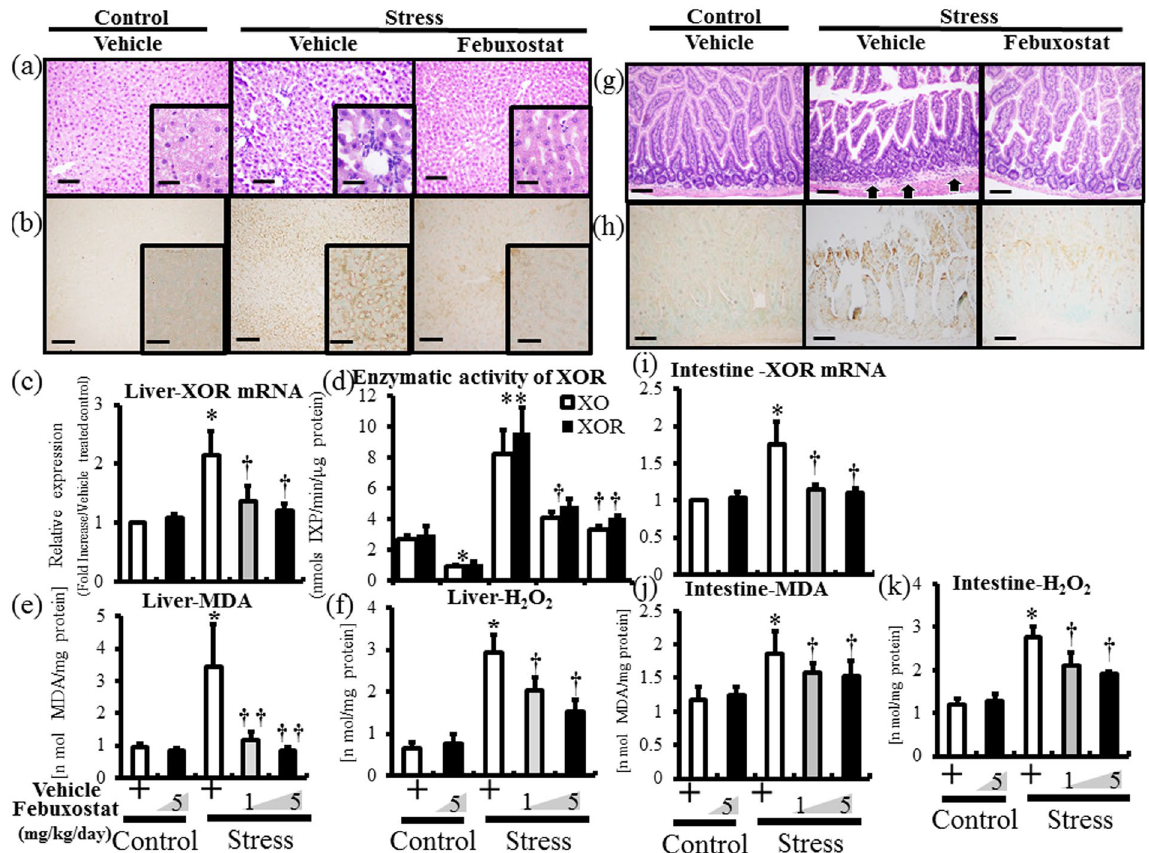
Figure 5. Febuxostat reduces stress-induced xanthine oxidoreductase activation and free radical production in liver and intestine. Expression levels of XOR in liver and intestine and activities of XOR in liver were analyzed in the control (non-stressed) and stressed mice treated with or without febuxostat (1 or 5 mg/kg/day), by immunohistochemistry, RT-PCR and XOR activity assay, respectively. The expression levels of MDA and H 2 O 2 production were analyzed in homogenized liver and intestine tissues of the control (non-stressed) and stressed mice treated with or without febuxostat (1 or 5 mg/kg/day) by ELISA. Data were analyzed by Student’s t-test and displayed as mean ± SD of 5–6 mice per group. Representative pictures of HE ( a ) and XO ( b ) staining of liver ( × 400 magnification, bar = 25 µ m; Inset, × 1000 magnification, bar = 10 µ m). ( c ) XOR mRNA expression in liver. * P < 0.002, compared with the vehicle-treated control mice, † P < 0.05, compared with the vehicle- treated stressed mice. ( d ) XO and XOR (XO + XDH) enzymatic activity in homogenized liver tissue. * P < 0.05 and ** P < 0.02, compared with the vehicle-treated control mice, † P < 0.03 and †† P < 0.02, compared with the vehicle-treated and stressed mice, respectively. MDA ( e ) and H 2 O 2 ( f ) in homogenized liver tissue. * P < 0.001, compared with the vehicle-treated control mice, † P < 0.05 and †† P < 0.001, compared with the vehicle-treated stressed mice. Representative pictures of HE ( g ) and XO ( h ) staining of intestine ( × 200 magnification, bar = 50 µ m). Arrows denotes thickening of submucosal areas with mononuclear cell infiltration. ( i ) XOR mRNA expression in intestine. * P < 0.001, compared with the vehicle-treated control mice, † P < 0.01, compared with the vehicle-treated stressed mice. MDA ( j ) and H 2 O 2 ( k ) in homogenized intestine tissue. * P < 0.03, compared with the vehicle-treated control mice, † P < 0.05, compared with the vehicle-treated stressed